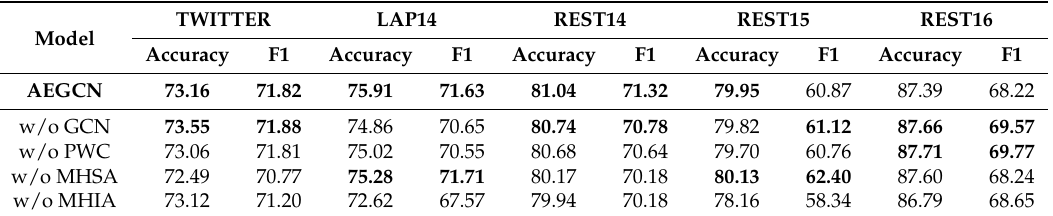
Table 3. Ablation study results (%). PWC: point-wise convolution; w/o: without. The best two results with each dataset are highlighted in